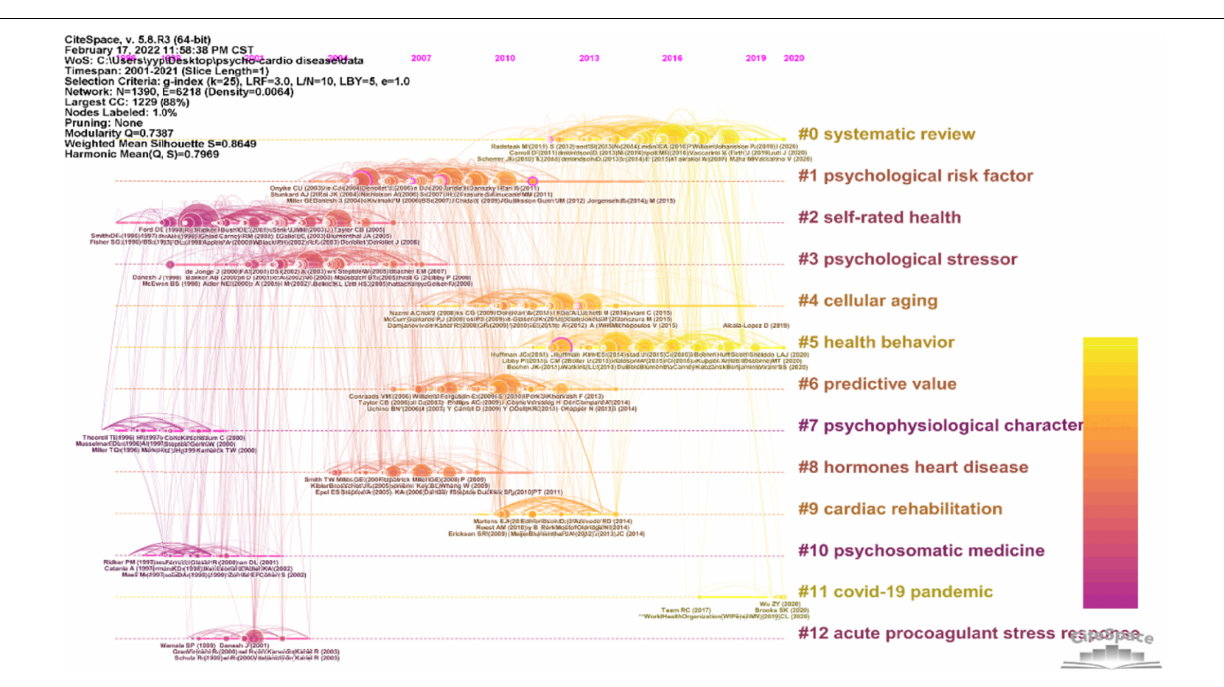
FIGURE 7 | Timeline view of references cited by publications about the psycho-cardiological disease and related